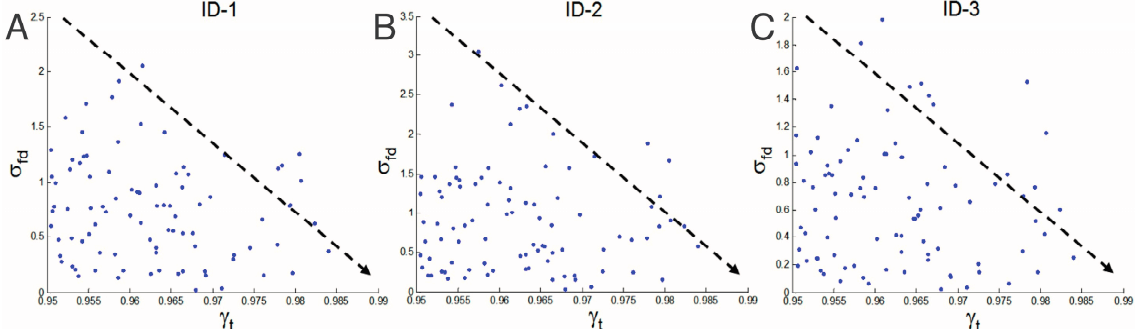
Figure 5. Scatter plots of the Multi-Chromatic Analysis (MCA) σ coinciding spatially with FPS. In detail, points in ( A ) are those coherence γ of the PS SB common to the populations shown in Figure 2A,D, those in ( B ) are common to the populations in Figure 2B,D, and those in ( C ) are common to the population in Figure 2C,D.